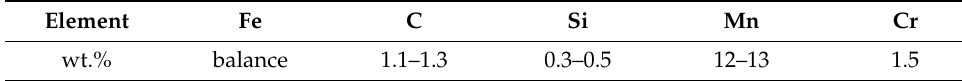
Table 1. Chemical composition of X120Mn12 (EN 1.3401) HMnS powder. Element Fe C Si Mn wt.%